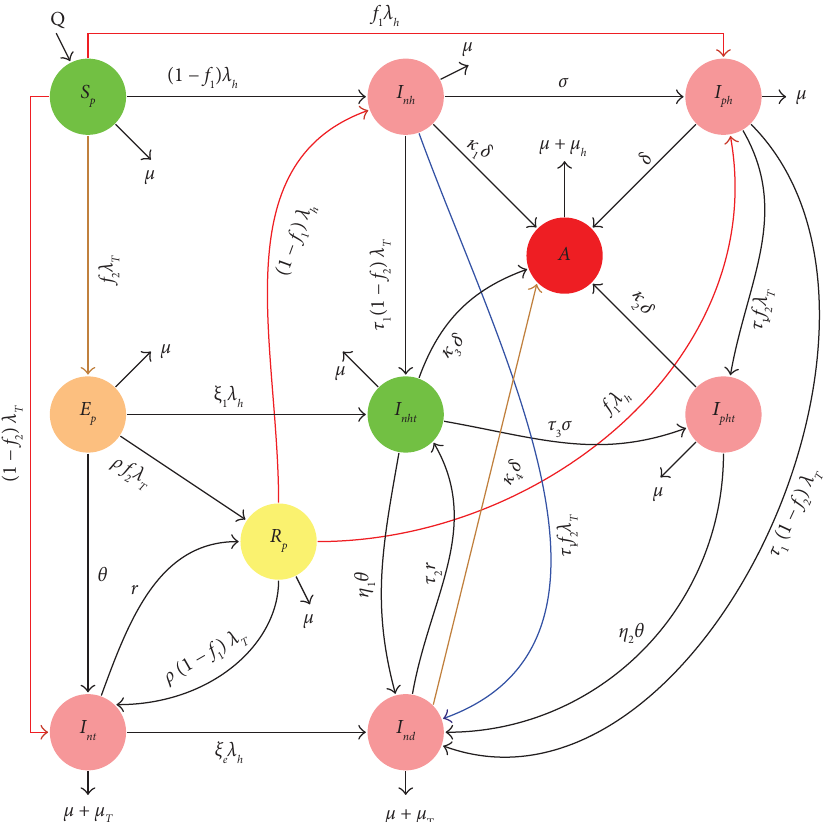
Figure 1: Schematic diagram of the industrial HIV-TB